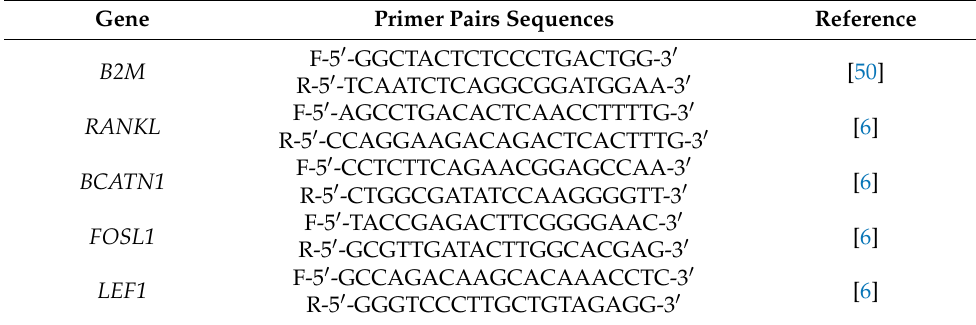
Table 4. Primers Set for gene